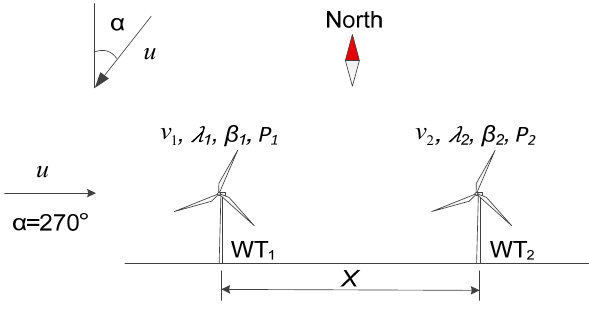
Figure 5. Layout of the wind farm with two NREL 5 MW wind turbines.